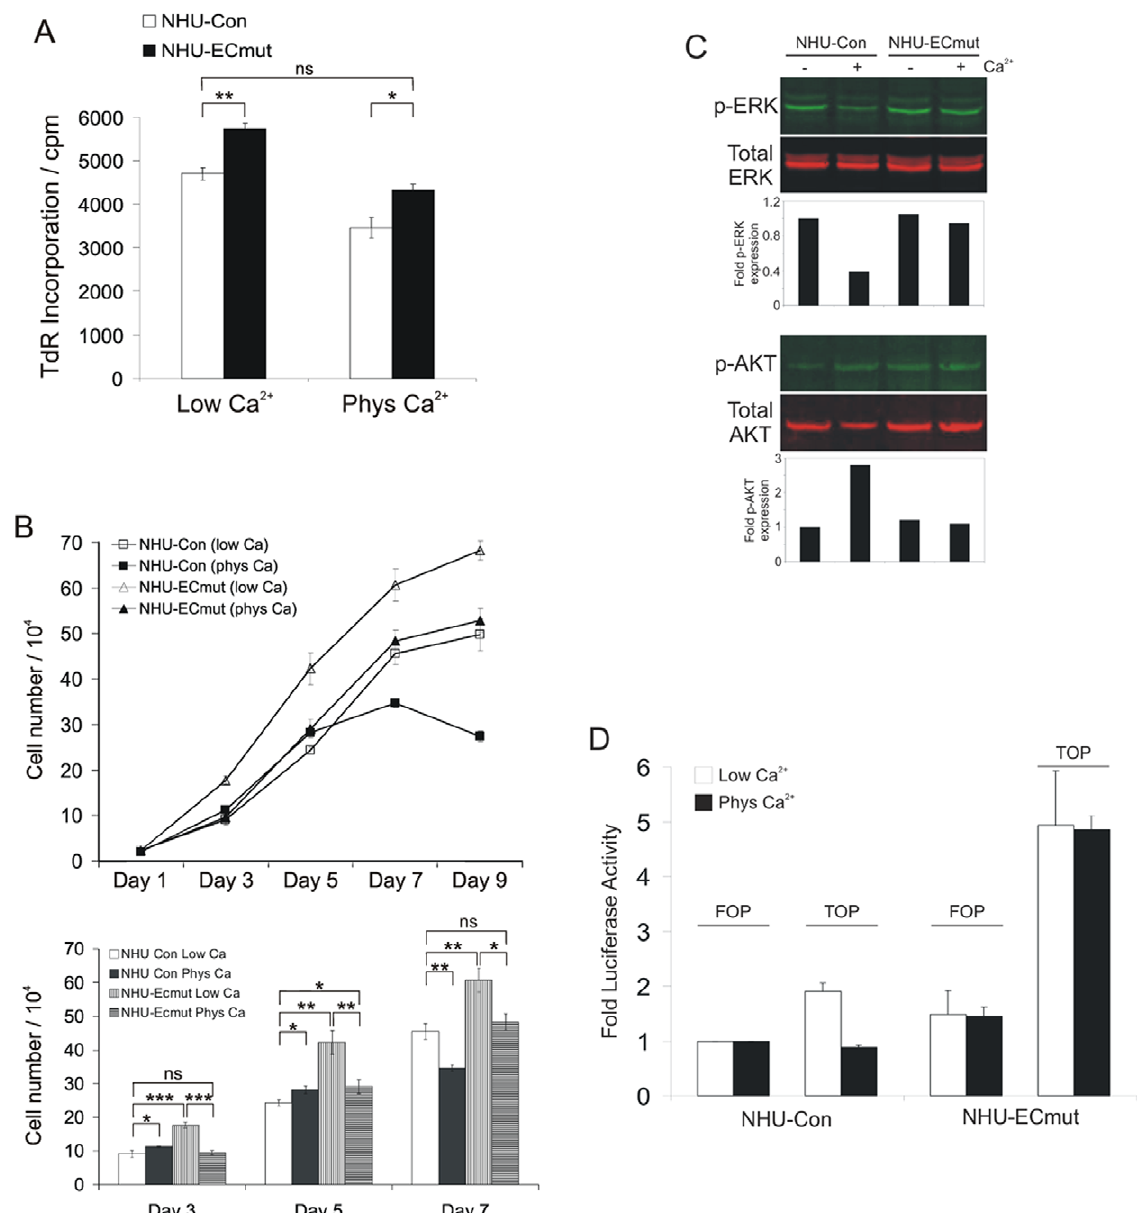
Figure 4. Loss of E-cadherin function enhances NHU cell proliferation and activates the EGFR/ERK and b -catenin/TCF signalling pathways. (A) NHU-Con and NHU-ECmut cells were seeded in 96-well plates and cultured as above. [ 3 H]-thymidine (TdR) precursor was added 24 hours later and 16 hours post-pulsing, cells were harvested and TdR uptake measured by scintillation spectrometry. Data represent mean of cpm counts ( 6 S.E.M.) for 12 replicate wells. ns, non-significant; *, P , 0.05; **, P , 0.01. Of note, NHU-Con cells showed higher proliferation levels in low calcium compared to physiologic calcium conditions, hence there was no apparent calcium-mediated enhancement in growth described above. This is because [ 3 H]-thymidine incorporation studies assessed proliferation in NHU cultures that were at . 50% confluence, thus missing the initial phase where cells exhibit calcium- mediated increased growth at low-density. (B) NHU-Con and NHU-ECmut cells were cultured in medium containing 0.09 mM (low Ca) or 2.0 mM (phys Ca) [Ca 2 + ] and proliferation assessed by cell counting as in Figure 1A. Each data point represents the mean ( 6 S.E.M.) of 3 replicates and results are representative of at least two independent experiments. Results for days 3, 5 and 7 are also presented in the form of bar graphs (lower panel) for the purpose of statistical analysis and clarity. ns, non-significant; *, P , 0.05; **, P , 0.01; ***, P , 0.001. (C) NHU-Con and NHU-ECmut cells were cultured in medium containing low (-Ca 2 + ) and physiological ( + Ca 2 + ) calcium levels for 24 hours and protein lysates were prepared. Expression of phospho-ERK (p-ERK) and -AKT (p-AKT) as well as total ERK and AKT was determined using primary and secondary antibodies described in Figures 1C and 2A. Densitometry was performed to determine fold induction of p-ERK and p-AKT expression following normalisation against total ERK and total AKT, respectively. Bar graphs represent results relative to the expression level for NHU-Con in low calcium (-Ca 2 + ). (D) NHU-Con and NHU-ECmut cells were transfected with the TCF/LEF firefly luciferase reporter TOPflash or the FOPflash control plasmid, alongside the Renilla luciferase expression vector pRL-tk. Four hours post-transfection, culture supernatants were adjusted for the desired level of calcium concentration, i.e. 0.09 mM (Low Ca 2 + ) or 2.0 mM (Phys Ca 2 + ). Cell lysates were prepared and reporter activity assessed in a 96-well format using the Dual-Luciferase Reporter Assay on a microplate reader for pair-wise detection of luminescence activity for each reporter. Fireflyluciferase values were normalisedagainst those ofRenilla luciferase and were thenexpressedas foldactivitywithrespecttothatobtainedfor FOPflash in NHU-Con cells cultured in low or physiological calcium. Bars represent mean fold Firefly luciferase activity ( 6 S.E.M.) for 6 replicate samples.